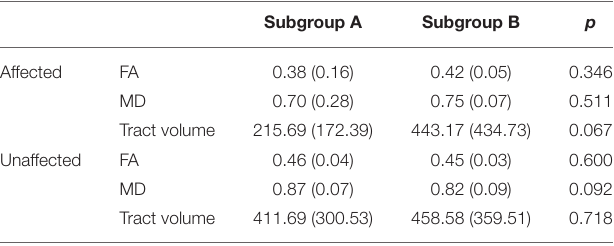
Values represent mean ( ± standard deviation). DTI, diffusion tensor imaging; PIVC, parieto-insular vestibular cortex; Affected, affected hemisphere; Unaffected, unaffected hemisphere; FA, fractional anisotropy; MD, mean diffusivity. * p < 0.05.